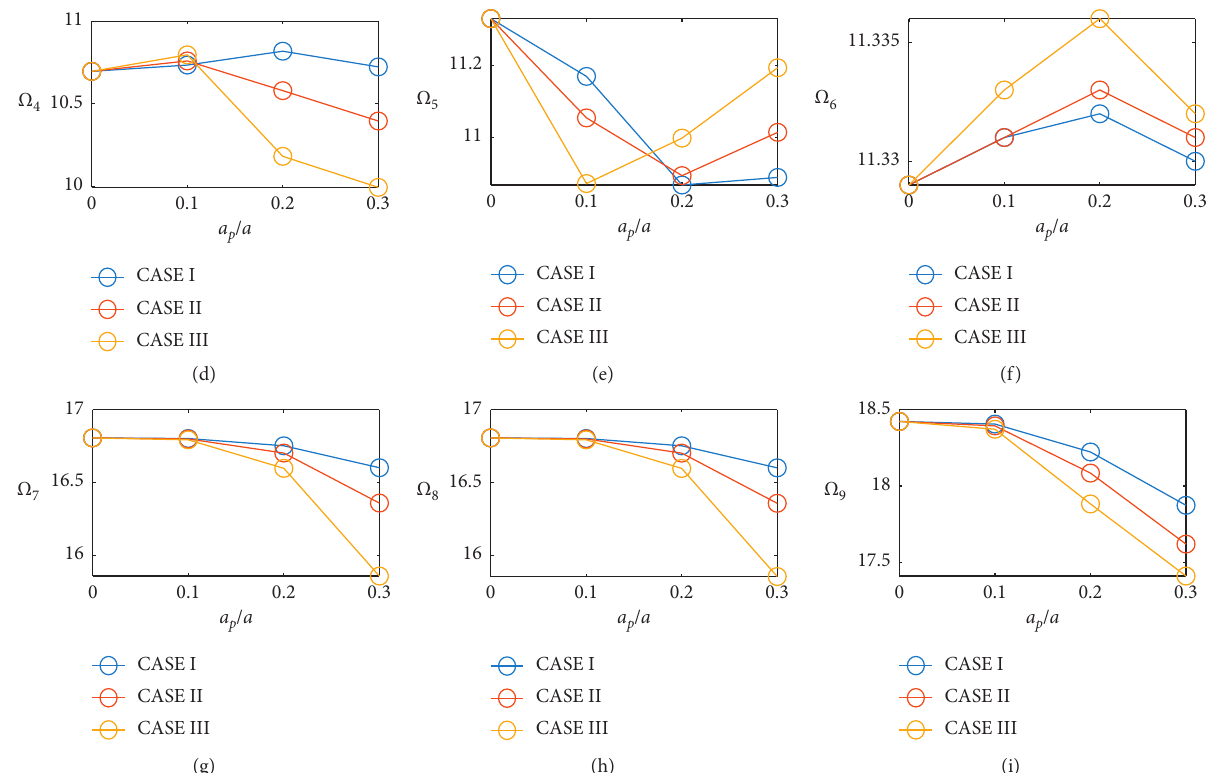
Figure 8: Nondimensional frequencies of the angle-ply laminate ([45/-45]s) with SSSS boundary condition, E 1/ E 2 � 20, and a � b � 10h and for different patch sizes and numbers.